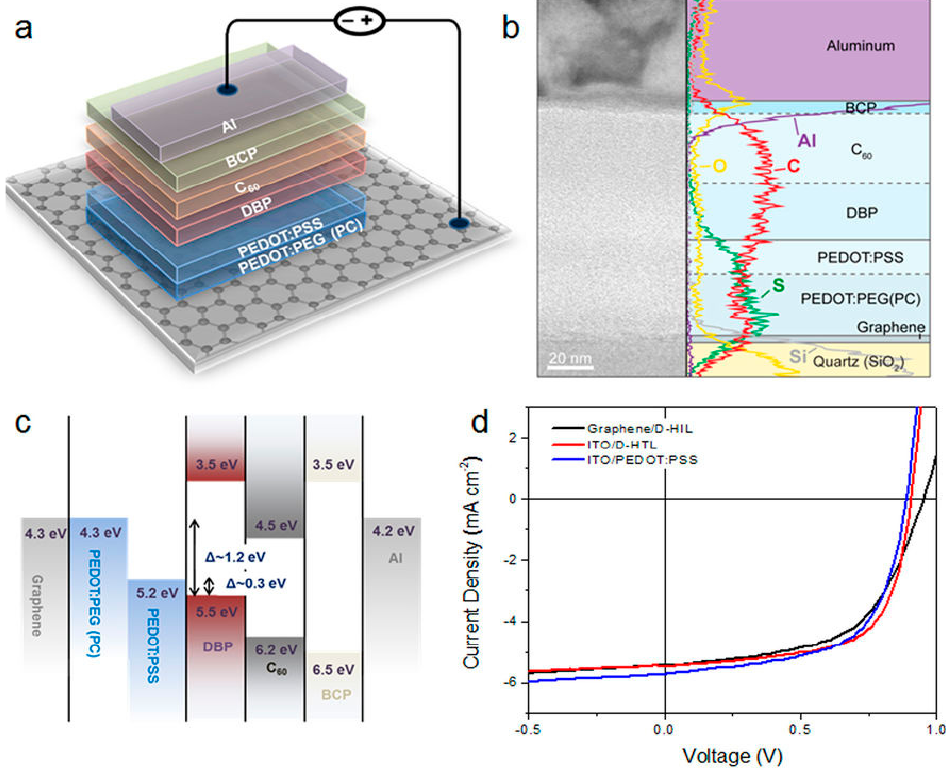
Figure 5. ( a ) Schematic representation of the PSC with G anode and structure G/PEDOT:PEG(PC)/PEDOT:PSS/DBP/C 60 /BCP/Al; ( b ) cross-sectional transmission electron microscope (TEM) image (left) of the device described in ( a ), with an energy-dispersive line scan on a diagram of the device cross-section (right); ( c ) flat-band energy level diagram of the PSC; ( d ) J–V characteristics of the G-based device compared to ITO reference cells (red and blue lines, respectively). Reproduced with permission from Ref. [57].